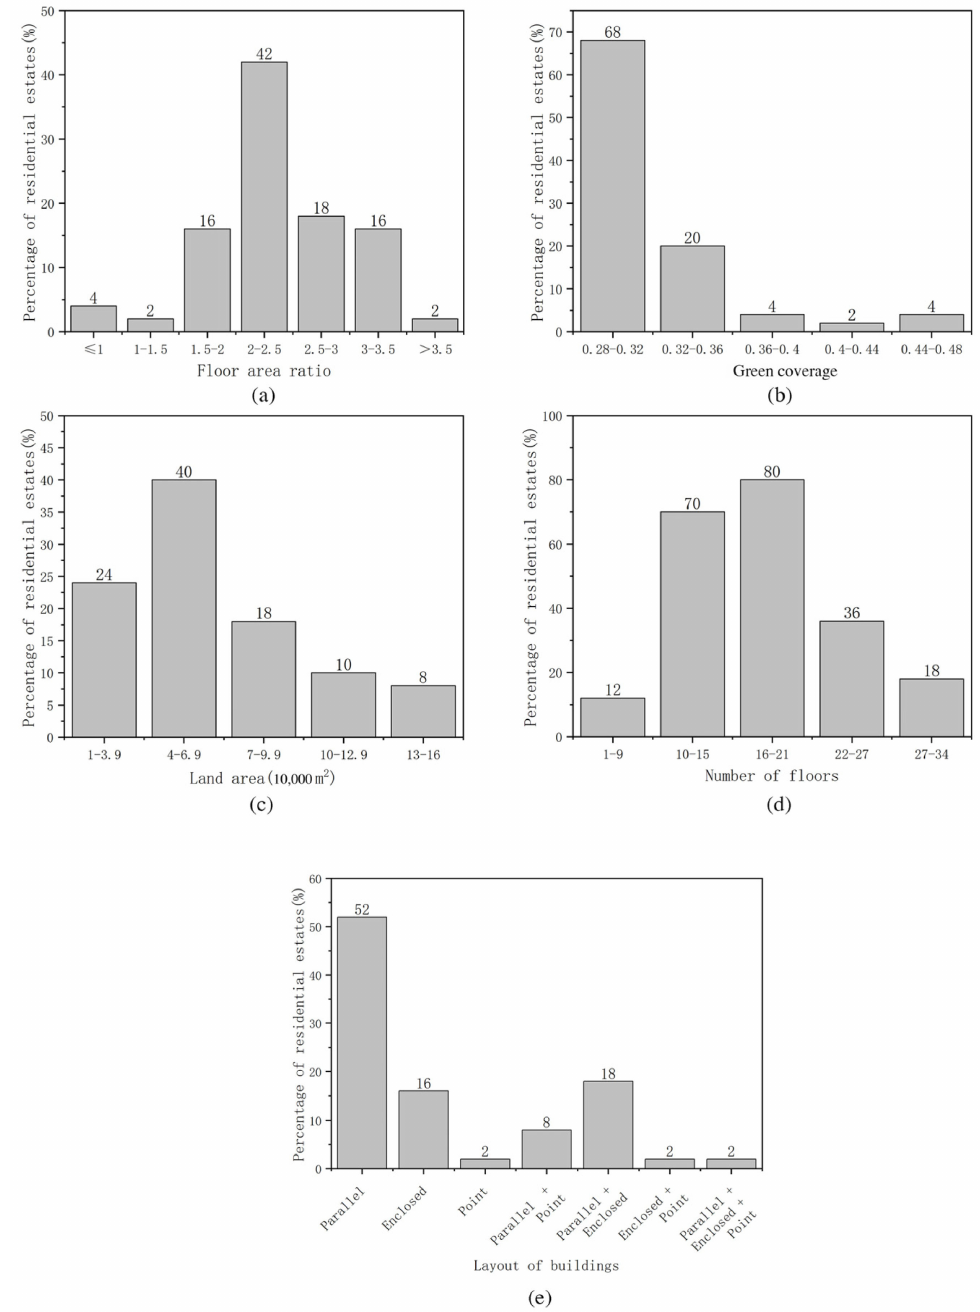
Figure 2. Floor area ratio ( a ), green coverage ( b ), land area ( c ), number of building floors ( d ), layout ( e ) of 50 high-rise residential estates in